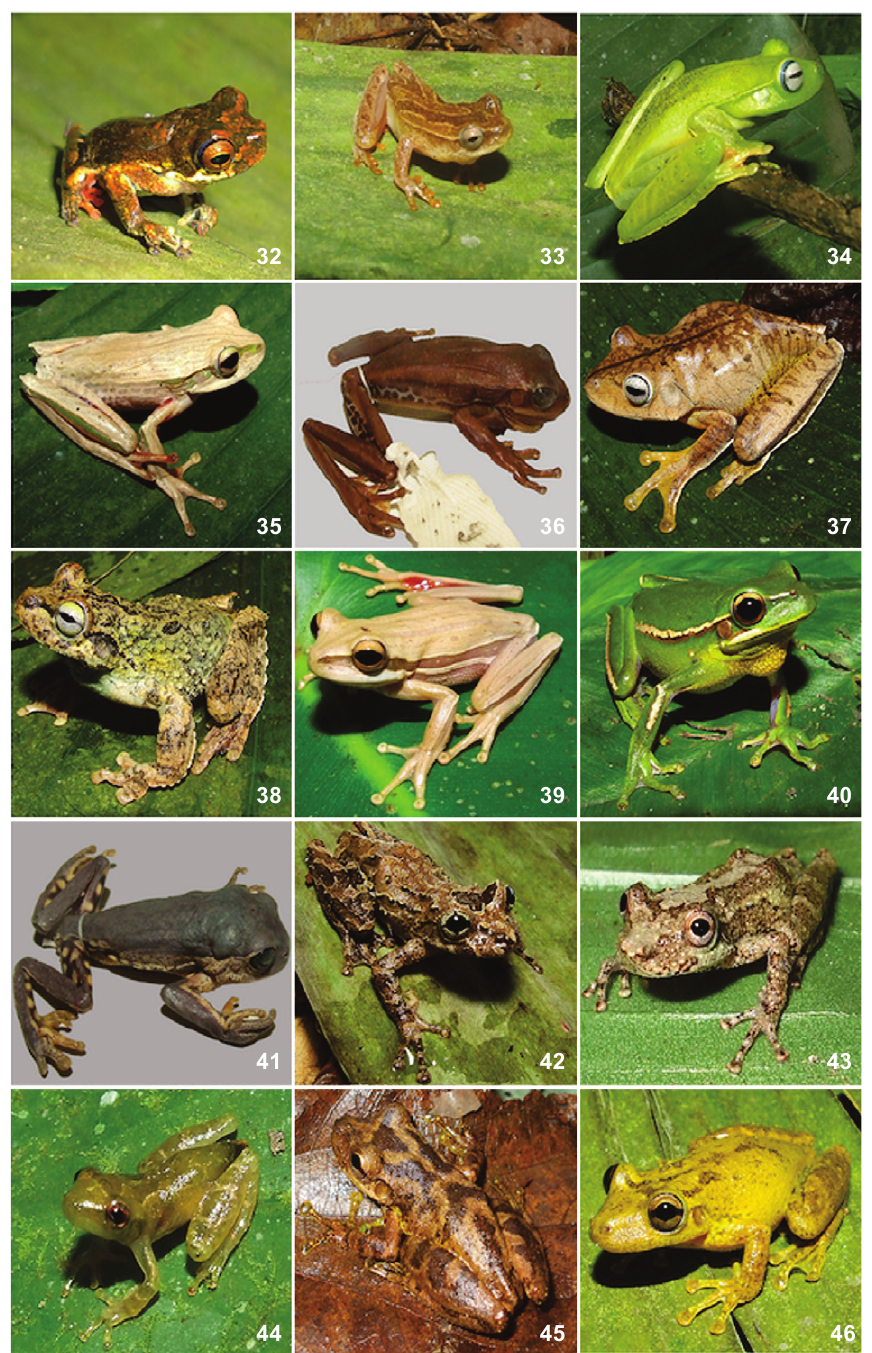
Figures 32-46. Anuran species sampled for the Parque Natural Municipal Nascentes de Paranapiacaba, Santo André, São Paulo state: (32) Dendropsophus microps ; (33) Dendropsophus minutus ; (34) Hypsiboas albomarginatus ; (35) Hypsiboas bischoffi ; (36) Hypsiboas cymbalum (MZUSP 74194); (37) Hypsiboas faber ; (38) Hypsiboas pardalis ; (39) Hypsiboas bandeirantes ; (40) Hypsiboas prasinus ; (41) Phyllomedusa rohdei (MZSUP 81306); (42) Scinax brieni ; (43) Scinax cf. perpusillus ; (44) Scinax crospedospilus ; (45) Scinax fuscovarius ; (46) Scinax hayii . Photos: Vivian C.